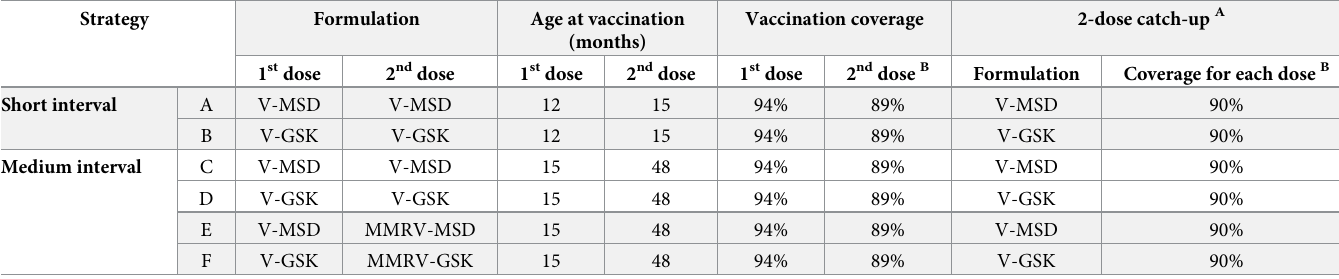
Table 1. Varicella vaccination